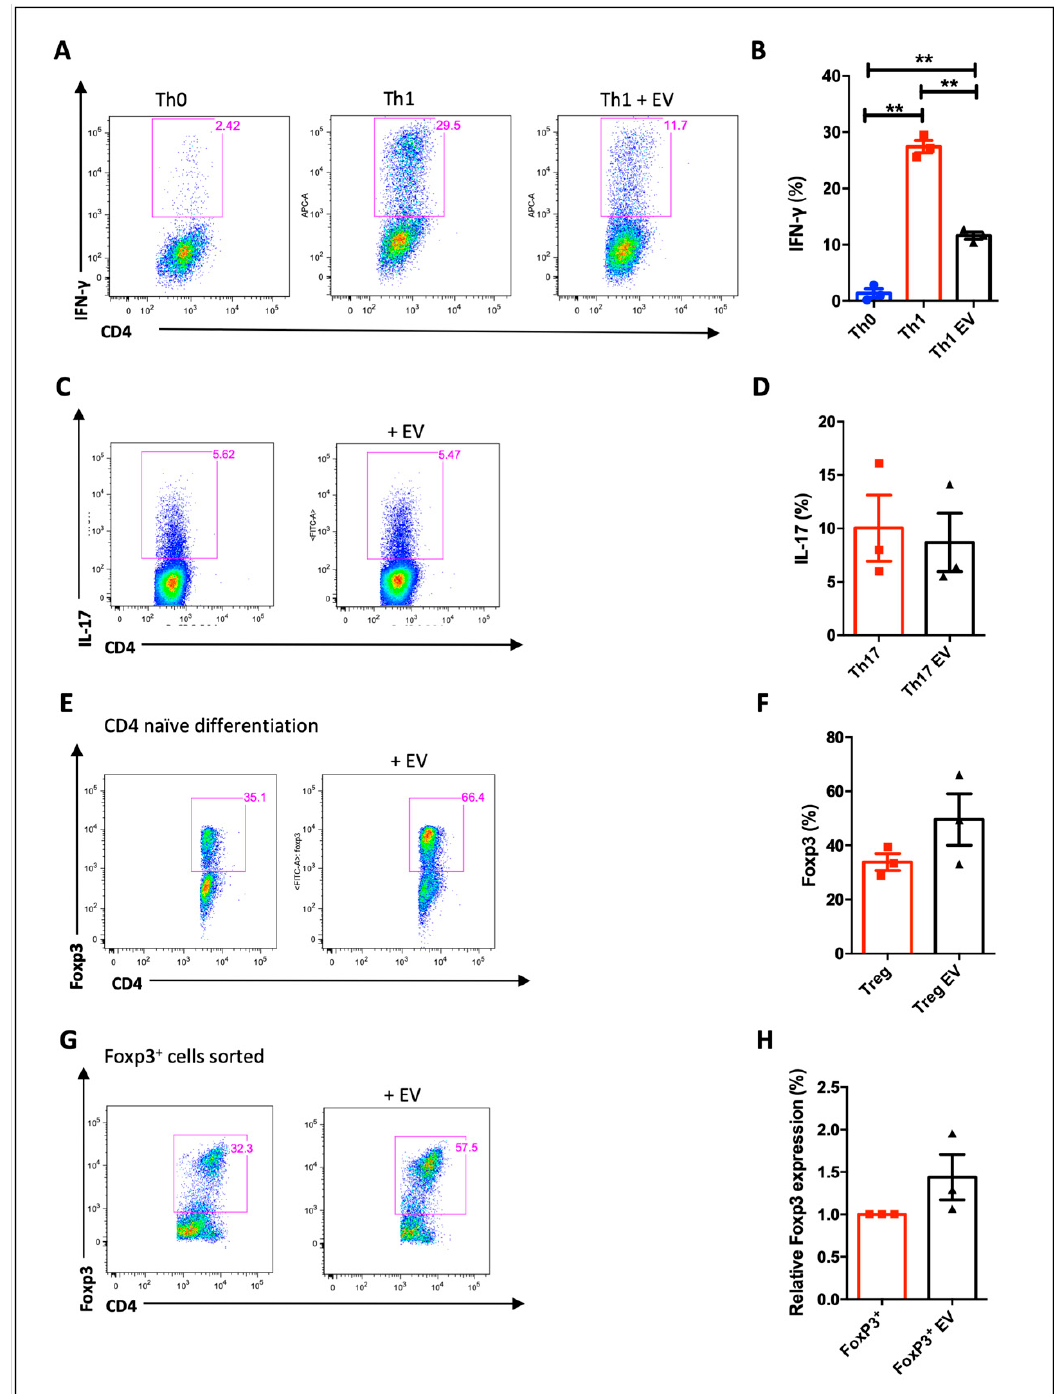
Figure 3. Effect of MSC-EVs on differentiation for T helper subsets: purified CD4 cells were differentiated for Th1 ( A,B ) Th17 ( C,D ) and Treg ( E,F ) and evaluated by detection of IFN- γ , IL-17 and Foxp3, respectively, by FACS. Foxp3+ cells were purified from spleen by FACS sorting and maintained in culture in the presence of IL-2 and MSC-EVs. Foxp3 expression was evaluated after 5 days in culture ( G,H ). Data are representative of 3 independent experiments (** p <